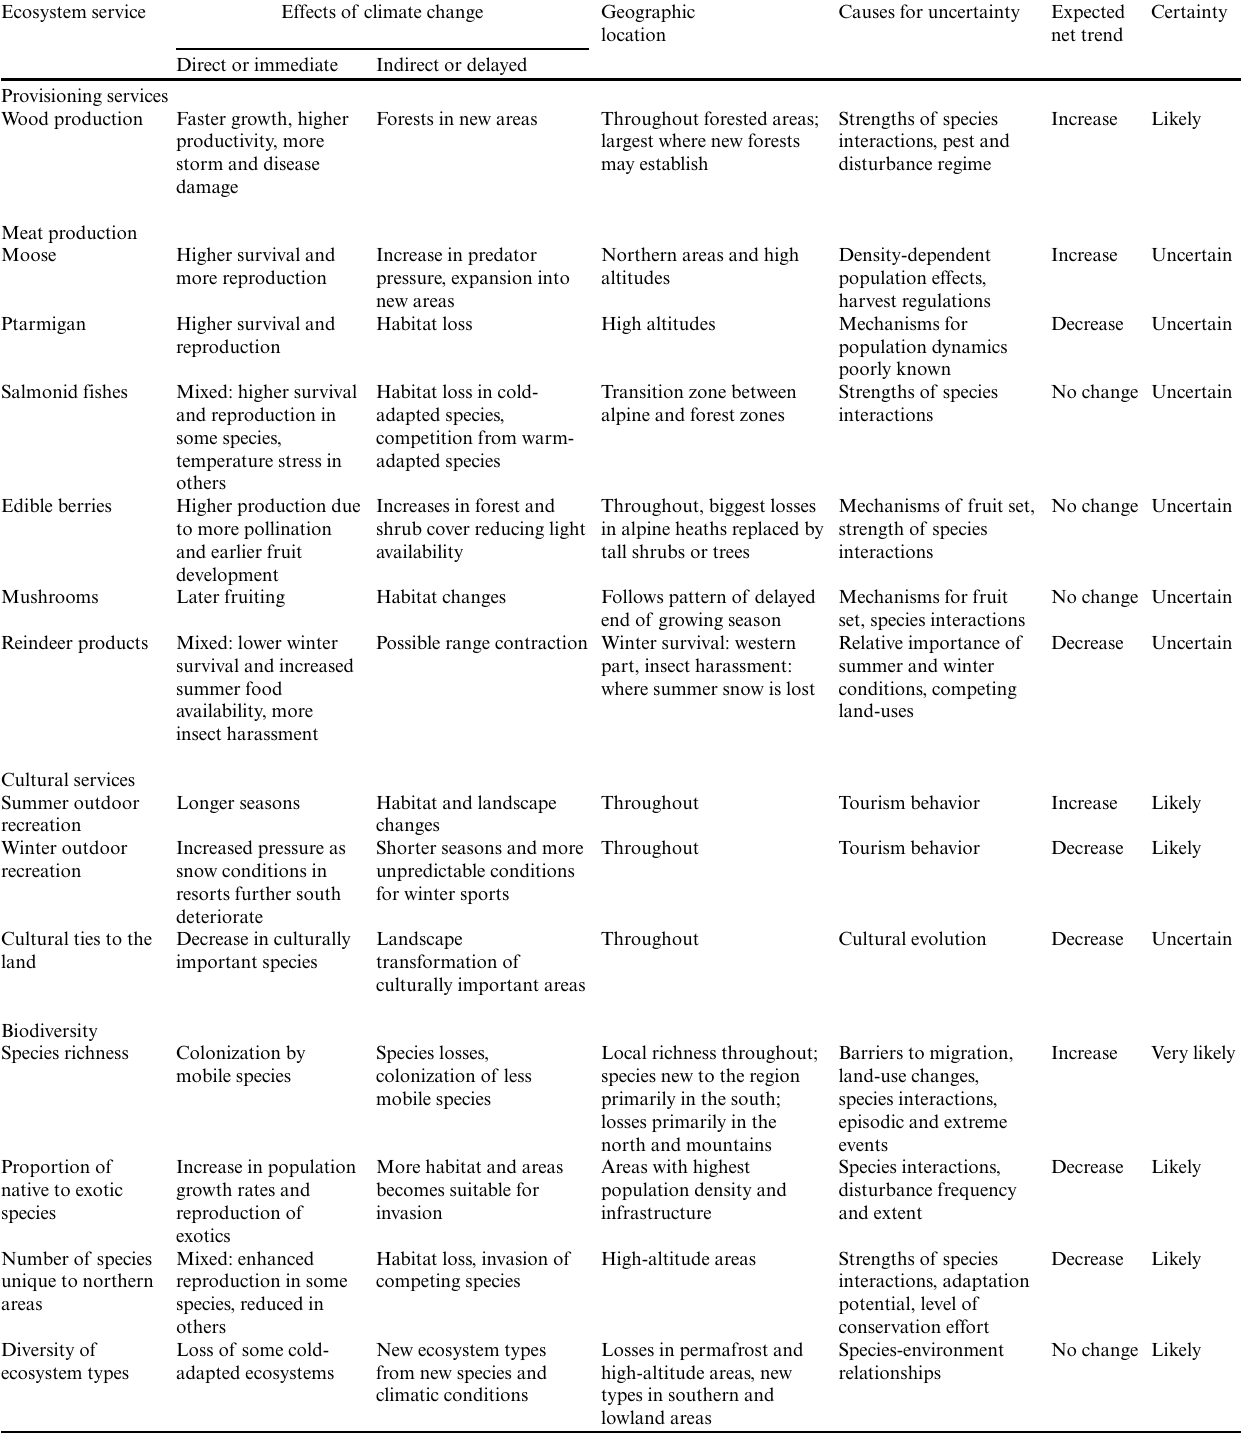
Table 1 . Projected effects of climate change on ecosystem services of importance to local communities provided by natural or seminatural ecosystems in the Barents Region expected during the 21st century. Expected net trend is the direction of change in the ecosystem service parameter (increase or